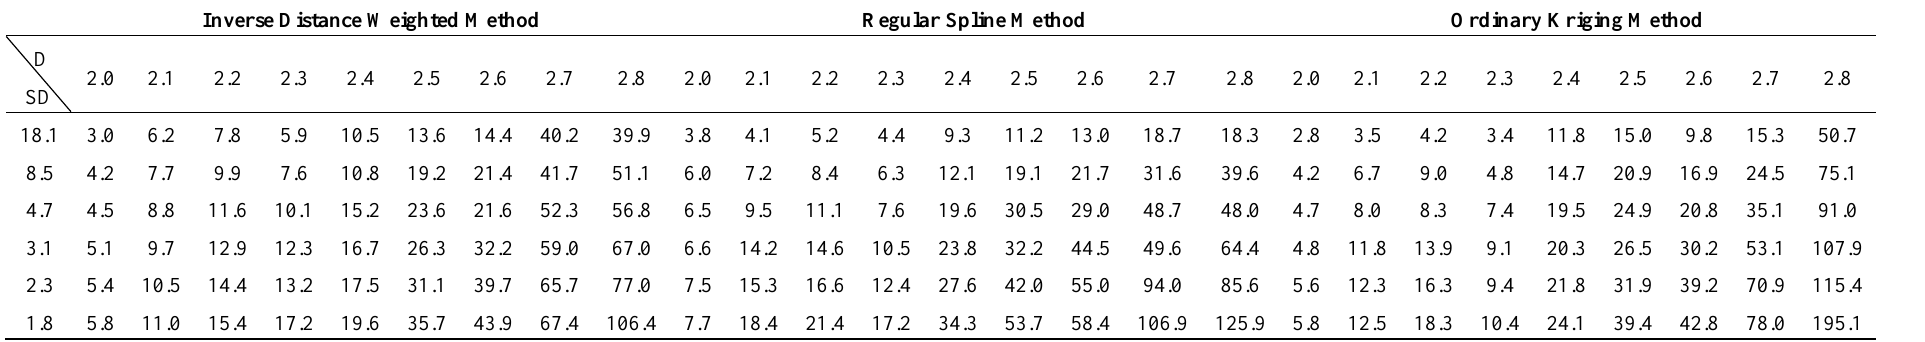
Table 8. The RMSE s under selective sampling mode (Unit: